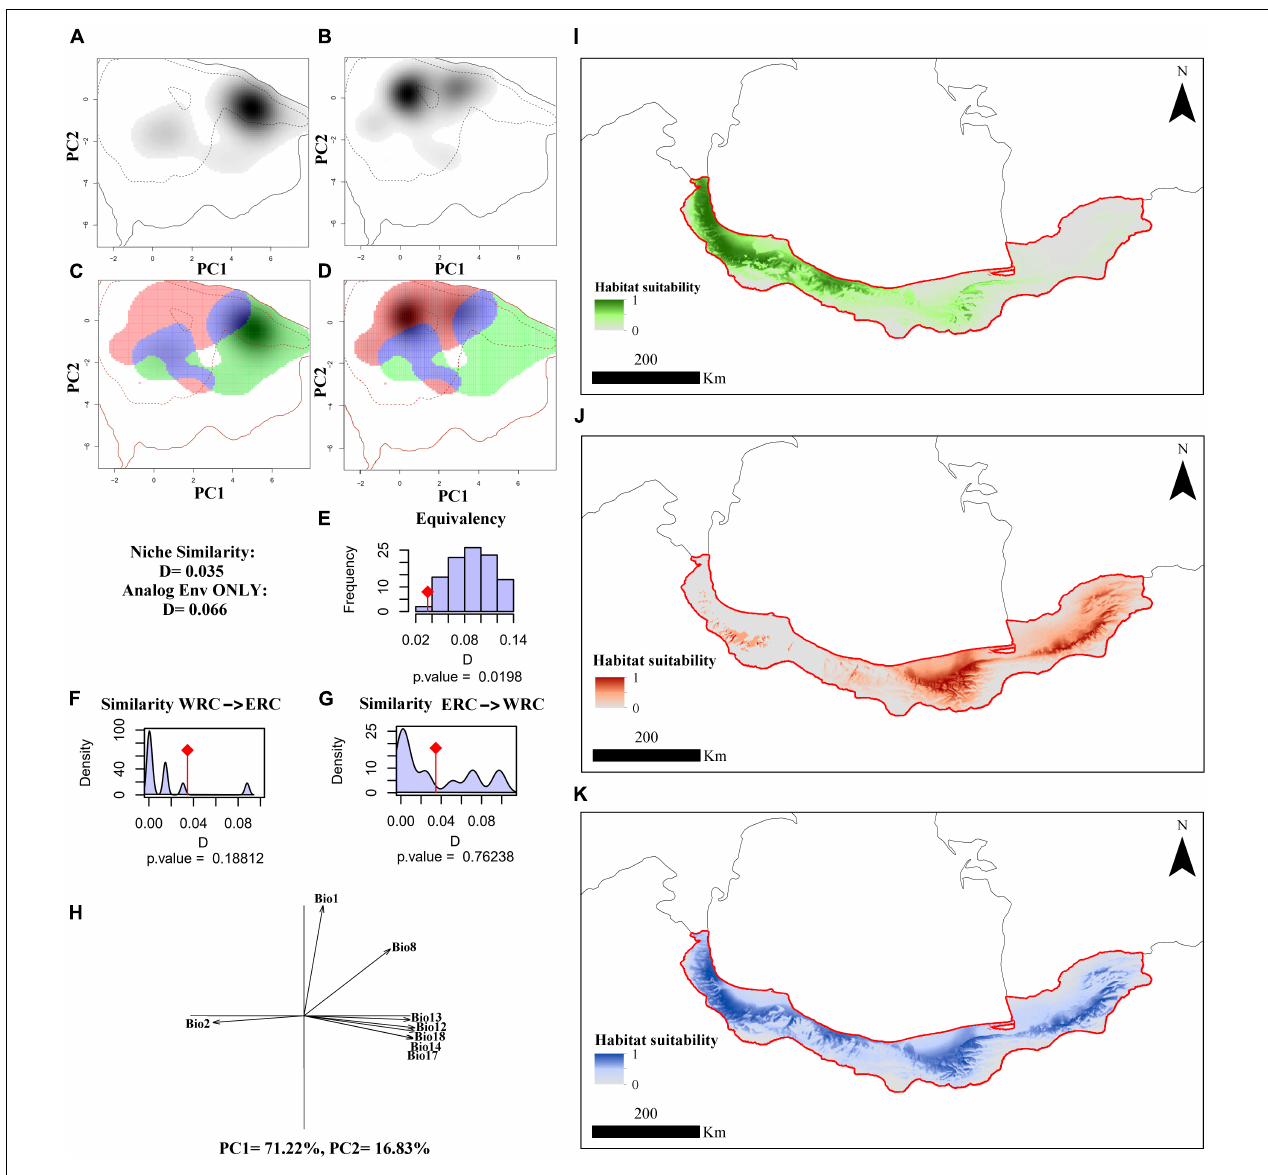
FIGURE 2 | The climatic niche of the Hyrcanian wood frog, Rana pseudodalmatina across Hyrcanian forests, Iran. Panels (A,B) illustrate the species’ niche in the western and eastern distribution ranges, respectively, along the two first axes of the PCA. The density of the species’ occurrences in the cell is shown in the gray shade. The solid and dashed contour lines represent 100 and 50% of the available (background) environment, respectively. Panels (C,D) represent the niche overlap values for western (WRC) and eastern regional clades (ERC), respectively. Histograms (E–G) show the observed niche overlap D between the two ranges (bars with a diamond) and simulated niche overlaps (gray bars) on which tests of niche equivalency (E) , niche similarity of WRC to ERC (F) , and niche similarity of ERC to WRC (A) . (H) The contribution of the climatic variables on the two axes of the PCA env and the percentage of inertia explained by the two axes. Potentially suitable areas are based on bio-climatic variables according to WRC (I) , ERC (J) , and species-level (K)